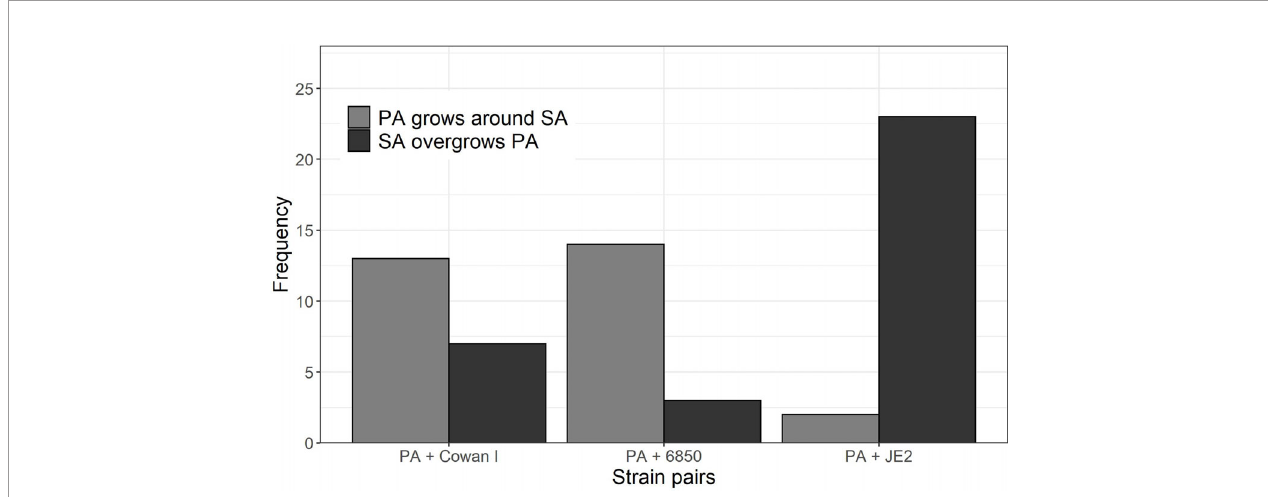
FIGURE 4 | Behavioral patterns when P. aeruginosa (PA) and S. aureus (SA) microcolonies come into close contact with each other. We scanned all time-lapse image series and manually counted the frequency of the following two events: (1) PA grows around SA microcolonies (n = 29), and (2) SA pushes PA aside and (sometimes) overgrows PA microcolonies (n = 33). The frequency of these two types of events signi fi cantly differ across the three strain pairs (Fisher ’ s exact test p < 0.0001). Visual examples for the two behavioral patterns can be found in the Supplementary Movies 2-4 (event 1: Movie S2 and S3; event 2: Movie S4). As a comparison, Movie S1 shows PA growing in monoculture. Data is from three independent experiments per PA-SA strain